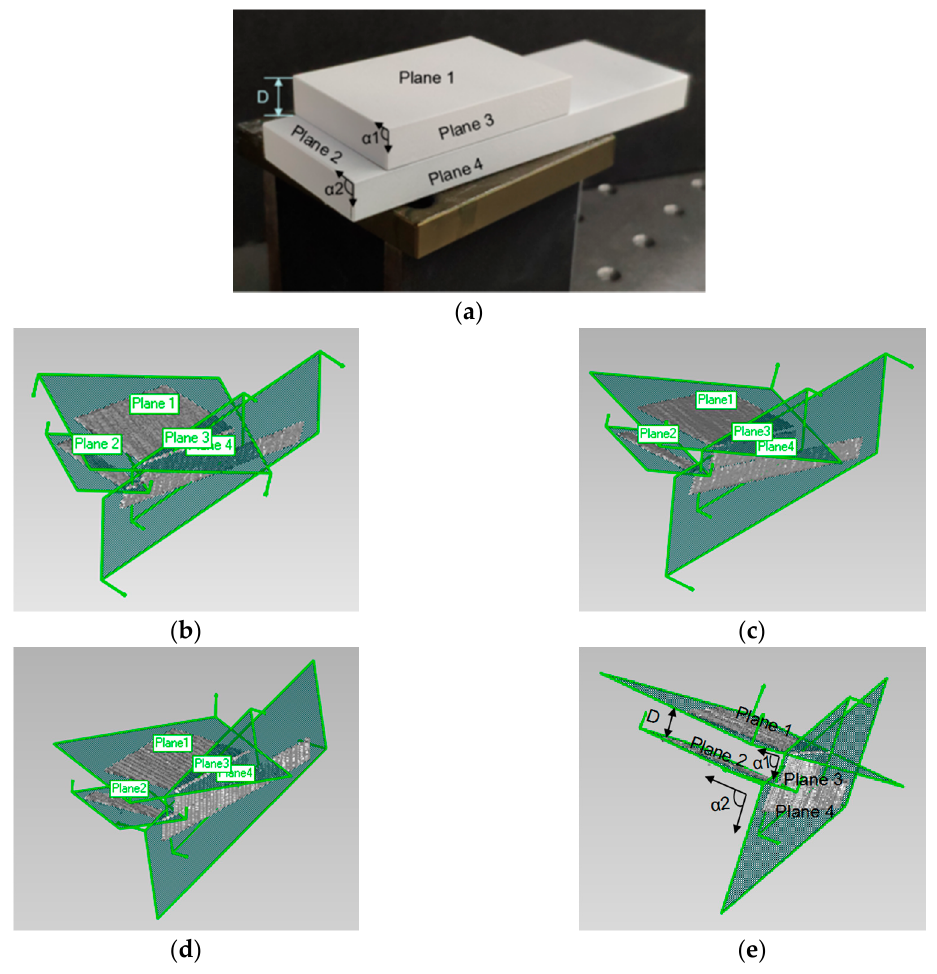
Figure 8. Standard object measurement experiments: ( a ) standard measurement object; point cloud and fitting planes of ( b ) Group A without GPR, ( c ) Group B without GPR, ( d ) the traditional method, and ( e ) the proposed method.